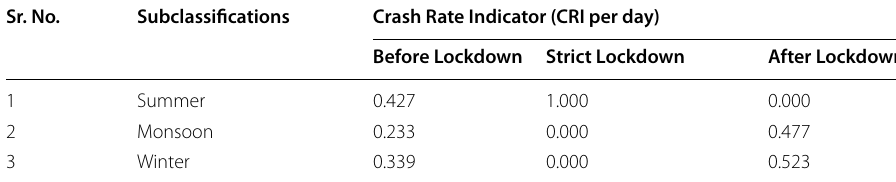
Table 11 CRI by season-wise analysis Sr.